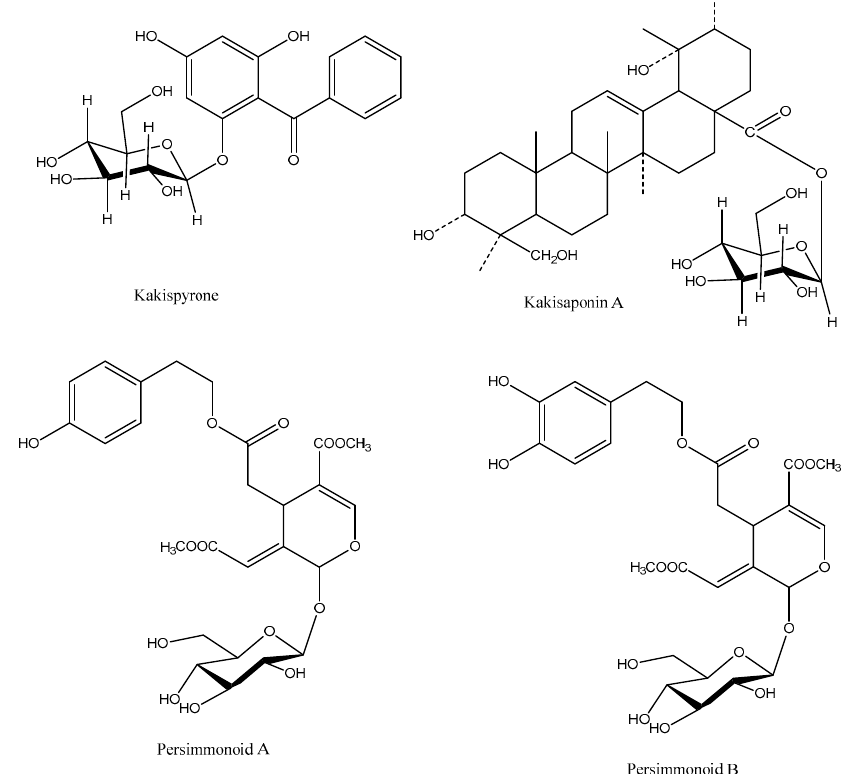
Figure 4. Chemical structures of kakispyrone, kakisaponin A, and persimmonoid A and B.